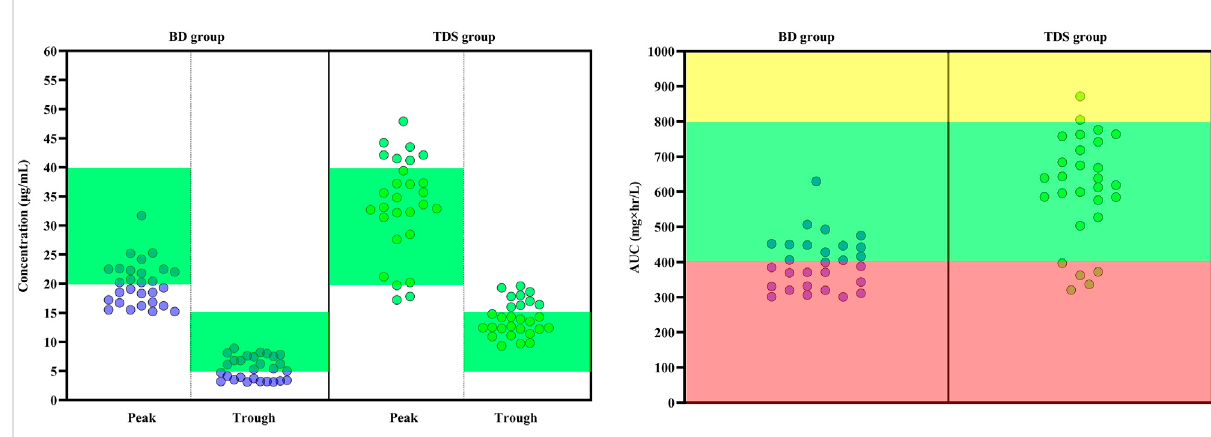
FIGURE 2 Key pharmacokinetic parameters following the administration of vancomycin with two different regimens in patients with augmented renal clearance. (Left) The peak and trough concentrations of vancomycin in the two groups. In the BD group, patients received 15 mg/kg vancomycin every 12 h and in the TDS group, patients received vancomycin at a dose of 15 mg/kg every 8 h. The green area indicates the optimal range of peak and trough levels (Trough: 5 to 15 mcg/ml and Peak: 20 to 40 mcg/ml). The green circles indicates each induvial patient of TDS group and the purple circles indicates each induvial patient of BD group. (Right) Calculated AUC/MIC is shown for both groups. The red area indicates the sub- therapeuticrange ofAUC(Lowerthan400 mg×hr/L).Theyellowareaalsoindicatesthesupra-therapeuticrangeofAUC(Higherthan800 mg×hr/ L). The green area also is the optimal range of AUC (Between 400 and 800 mg × hr/L). AUC: Area under curve, BD: Indicates every 12 h group, MIC: Minimum inhibitory concentration, TDS: Indicates every 8 h